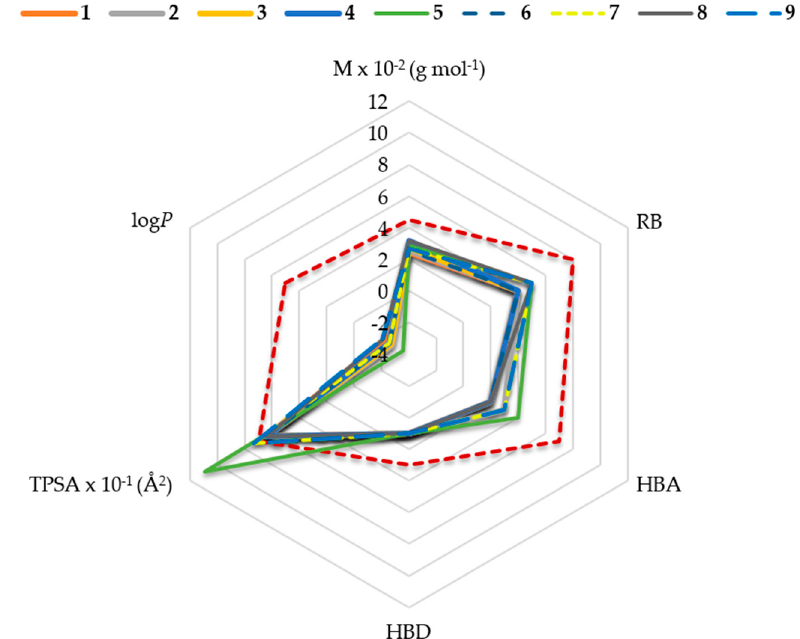
Figure 2. Physicochemical characteristics (molecular weight (M), number of hydrogen bond donors and acceptors (HBD and HBA), number of rotating bonds (RB), lipophilicity (logP) and topological polar surface area (TPSA)) of nicotinamide derivatives in relation to the reference values set for blood–brain barrier (BBB) acting drugs presented here by the red dotted line [46]. Table 1. In silico prediction of tested nicotinamide derivatives ( 1 – 9 ) passive transport to central nervous system (CNS) through the BBB, according to Discovery Studio Client’s ADMET Descriptors protocol. R denotes substituent and its position on the phenyl ring.